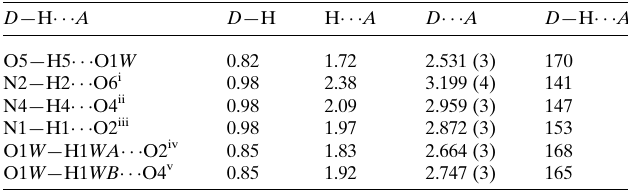
Table 3 Hydrogen-bond geometry (A˚ , (cid:4) ) for II .